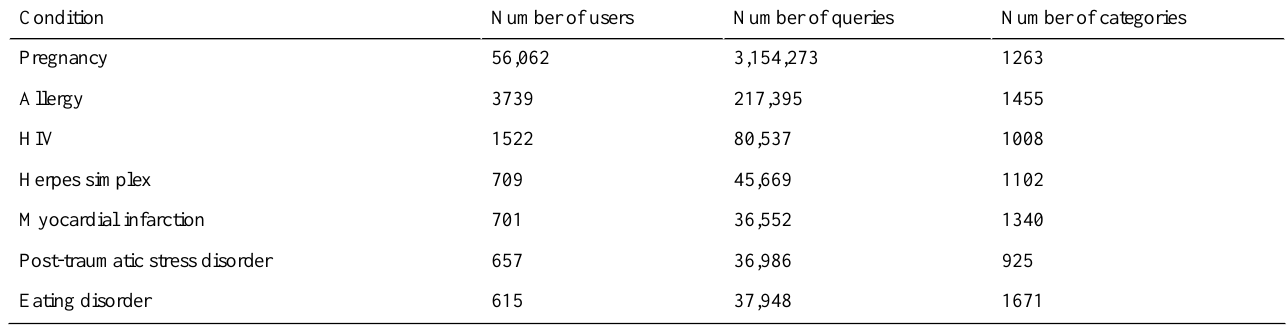
Table 5. Medical conditions analyzed for precursor